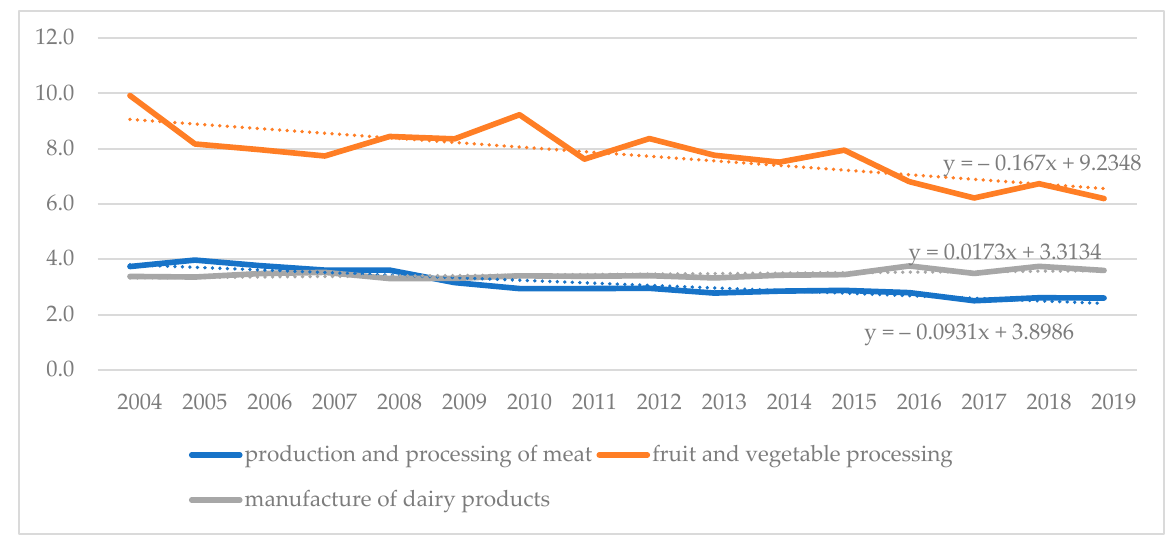
Figure 1. Electricity consumption in selected branches of the food industry in kWh per PLN 100 of sold production (in constant prices). Source: own elaboration based on [77,80,82,83]. Different trends were observed in electricity consumption per employee. They were growing, even in those activities where employment increased (Table 6). This was because the increase in employment in these industries was lower than the total increase in electricity consumption. Table 6. Employment in the food industry a and electricity consumption per employee (in medium and large companies).